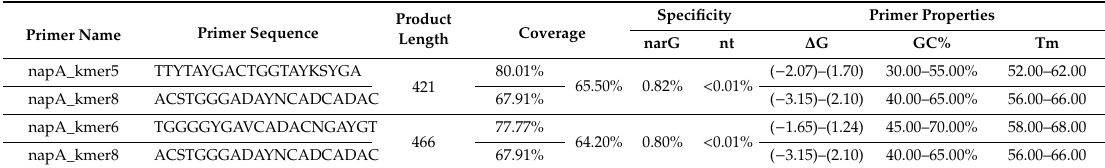
Table S1. The primer named as napA_kmer5 (TTYTAYGACTGGTAYKSYGA) possessed the highest coverage, covering 80.01% of all sequences. The top three primers with the highest coverage and their basic properties are listed in Table 1. Table 1. napA primers with basic